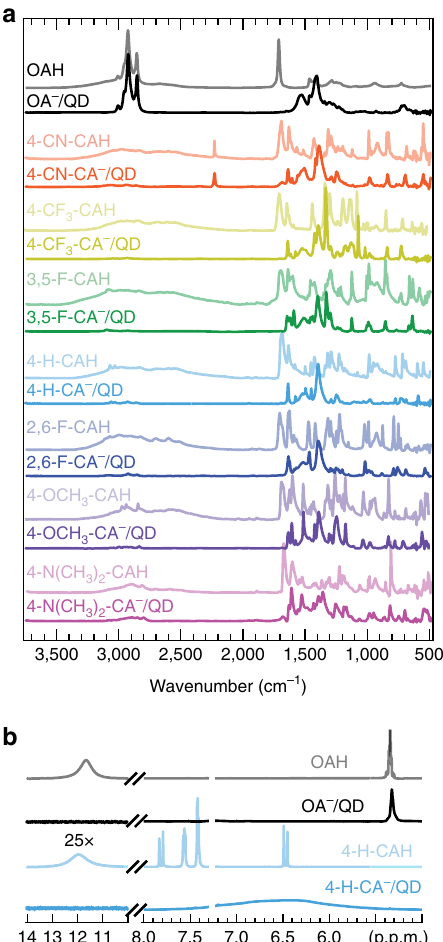
Figure 2 | Surface analysis of PbS QDs before and after ligand exchange and PCR purification. ( a ) FTIR spectra of neat ligand (lighter traces) and ligand/QD complex (darker traces) films. ( b ) 1 H NMR spectra in CDCl 3 of neat ligand (lighter traces) and ligand/QD complexes (darker traces). Both FTIR and 1 H NMR spectroscopic analysis suggests the efficient exchange of native OA (cid:2) ligands for R-CA (cid:2) and removal of excess R-CAH and OAH through PCR